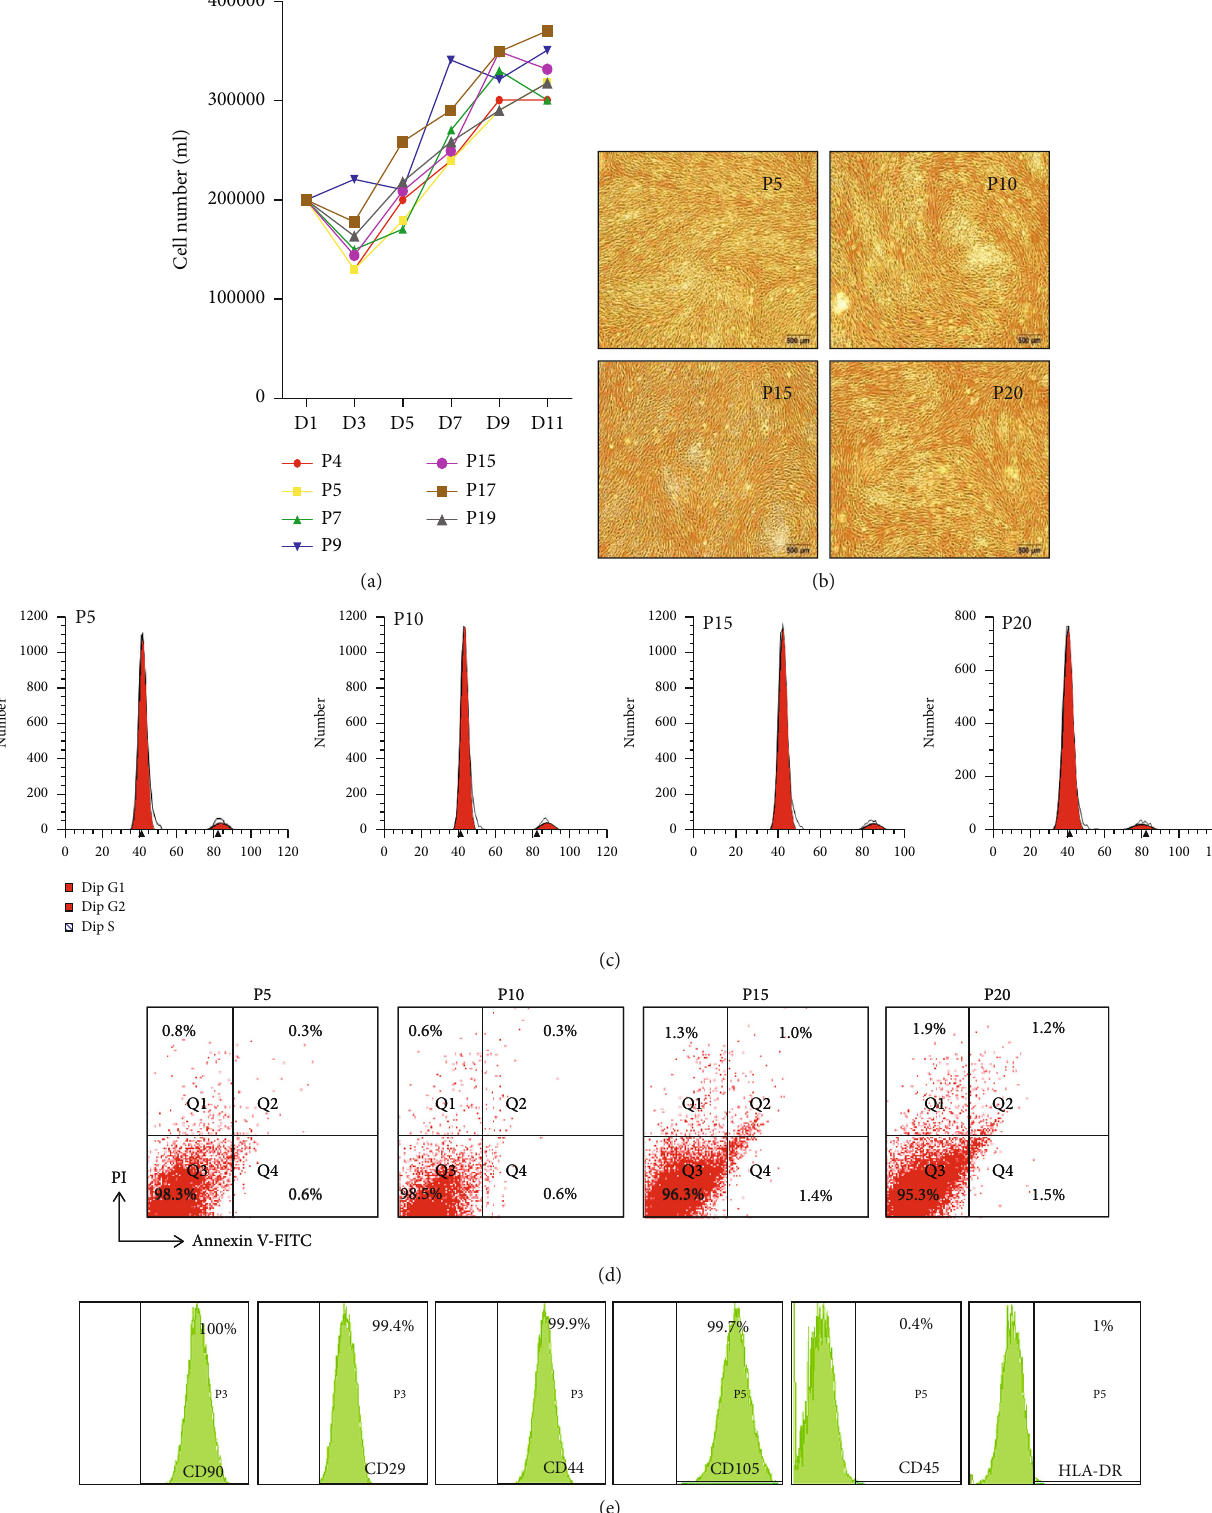
Figure 2: The passages of HUC-MSCs without a ff ecting the characteristics of stem cells. (a) Proliferation curve of HUC-MSCs. There were little changes in the proliferation rate of HUC-MSCs from passage 4 to passage 19. (b) Cellular senescence assay of di ff erent passages of HUC-MSCs. (c) Cell cycle of di ff erent passages of HUC-MSCs. (d) Apoptosis analysis of di ff erent passages of HUC-MSCs. (e) Identi fi cation of MSC markers for the 20th-generation HUC-MSCs by fl ow